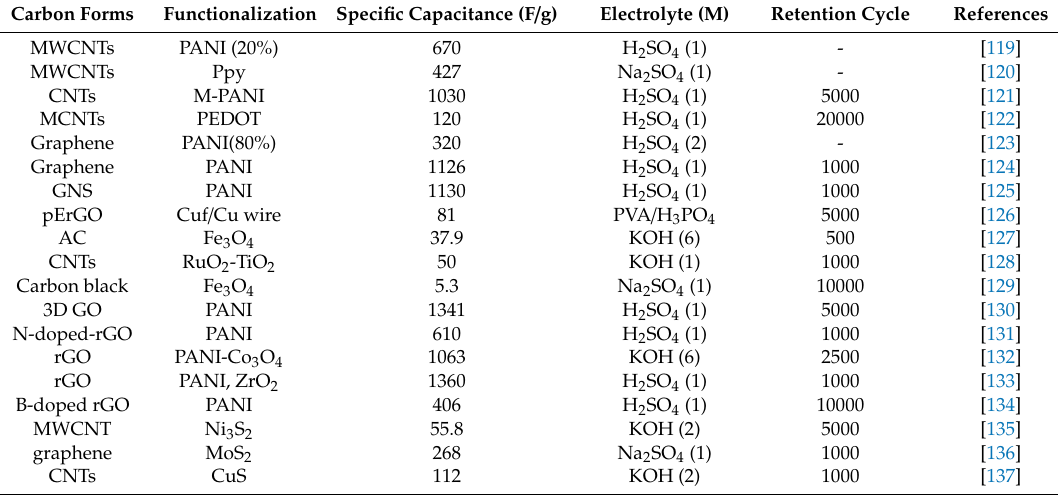
Table 1. Di ff erent carbon forms, their modification and application in supercapcitors. GNS: Table 1. Different carbon forms, their modification and application in supercapcitors. GNS: graphene